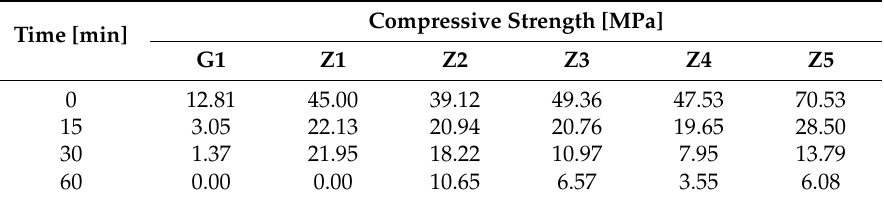
Figure 8. Compressive strength in time function. Table 10. Compressive strength in time